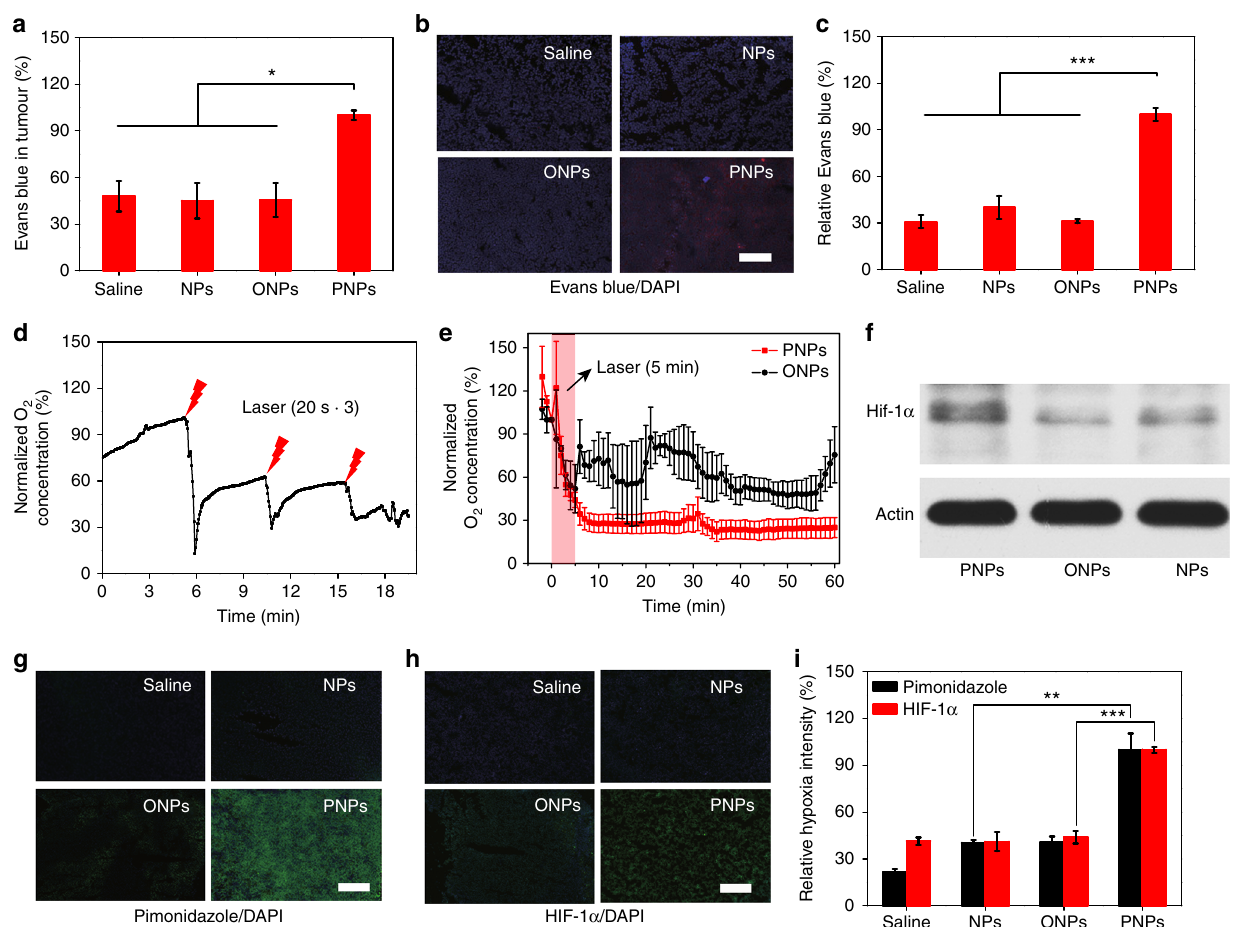
Fig. 3 Increased tumour permeability and hypoxia mediated by deoxygenated PNPs under laser irradiation. a The accumulation of Evans blue in tumours was quanti fi ed 24 h after the intravenous injection of PNPs and 3 h after laser irradiation (5 min, 808 nm, 400 mW cm − 2 ), ( n = 3). b Ex vivo fl uorescence images of Evans blue (red) in tumour sections from a . Nuclei were stained with 4 ′ ,6-diamidino-2-phenylindole (DAPI) (blue), (scale bar, 100 µ m), ( n = 3). c Relative quanti fi cation of Evans blue accumulation in b ( n = 4). d Changes in dissolved oxygen (DO) during three cycles of laser irradiation (808 nm, 2 W cm − 2 , 20 s) after intratumoural administration. e Changes in DO after laser irradiation (808 nm, 400 mW cm − 2 ) for 5 min at 24 h post-intravenous injection ( n = 3). f Western blot of intratumoural hypoxia-inducible factor-1 α (HIF-1 α ) expression at 24 h after laser irradiation. g , h Tumour sections were stained with anti-pimonidazole antibody (green), anti-HIF-1 α antibody (green) and DAPI (blue) at 24 h post irradiation (scale bars, 200 µ